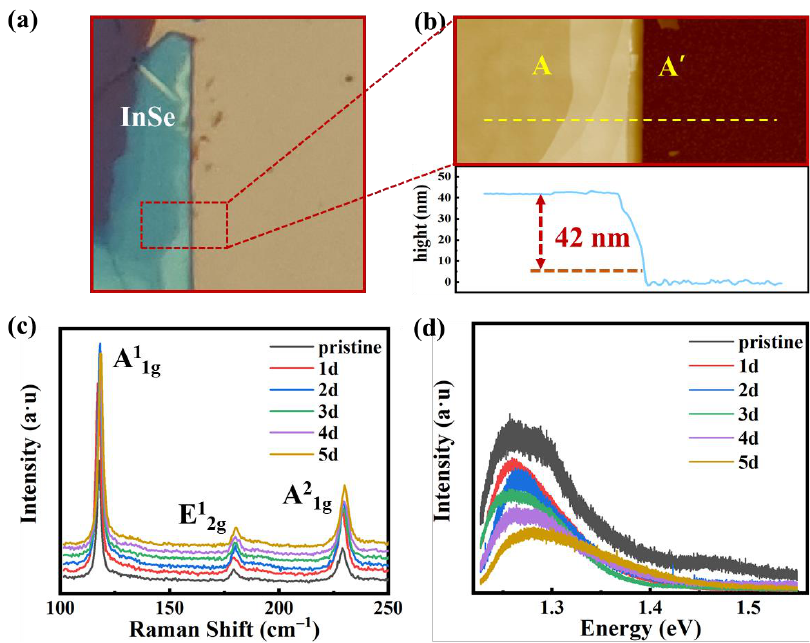
Figure 1. ( a ) Photo image of exfoliated InSe flake on substrate of HfO 2 /Si and the thickness is tested in the dash line area. ( b ) AFM result of thickness along AA’ and the thickness is 42 nm, corresponding to the green InSe flakes. ( c , d ) The Raman and PL spectra of 42 nm InSe flake preserved for 1 day, 2 days, 3 days, 4 days, and 5 days, respectively.